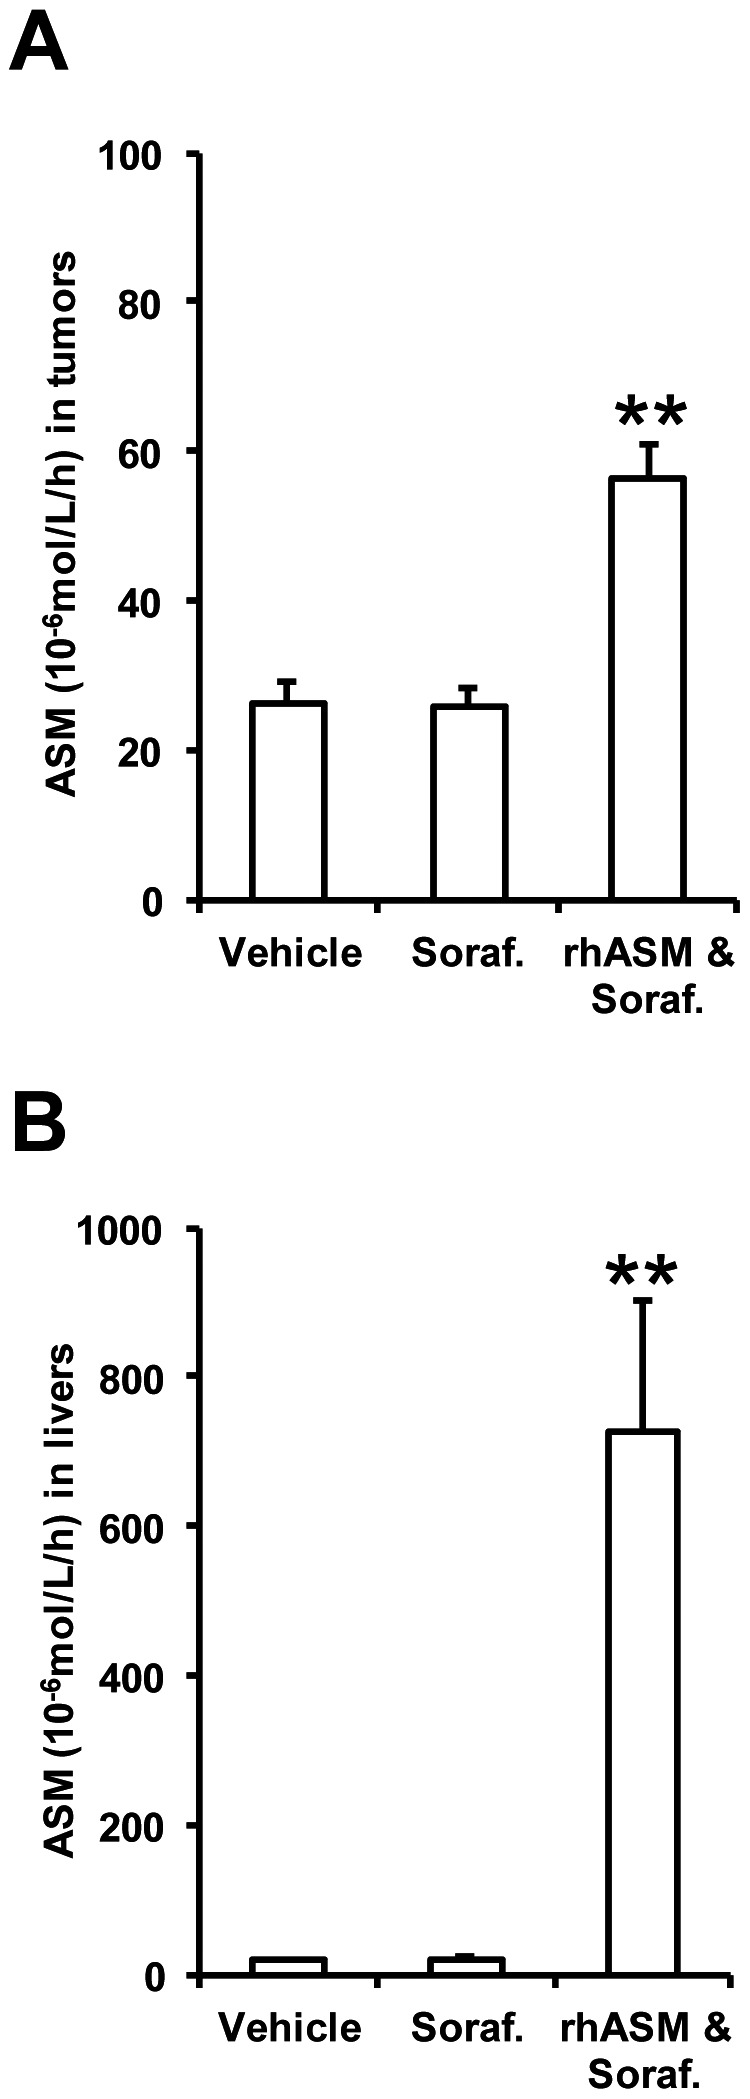
Localization of rhASM in subcutaneous tumors and livers.(A) ASM activity in tumor extracts of rhASM/sorafenib treated mice was significantly higher (ANOVA, df (2,30), F = 22.58, p<0.001; Dunnett's post hoc test p<0.001) than control, while sorafenib had no effect on baseline ASM activity. (B) ASM activity in liver extracts of rhASM/sorafenib treated mice also was higher than vehicle treated mice (ANOVA, df (2,30), F = 11.17, p<0.001; Dunnett's post hoc test p<0.001), and sorafenib had no effect on baseline ASM activity. Of note, animals in the combination treatment group had >12 times higher ASM activity in livers than in tumors, demonstrating the hepatotropic nature of rhASM during chronic administration and relatively modest distribution to the subcutaneous tumors. ** p<0.001. Note: Y-axes activity (10−6 mol/L/hour) was measured in equal parts of 20% weight/volume tissue extracts as described in Materials and Methods.